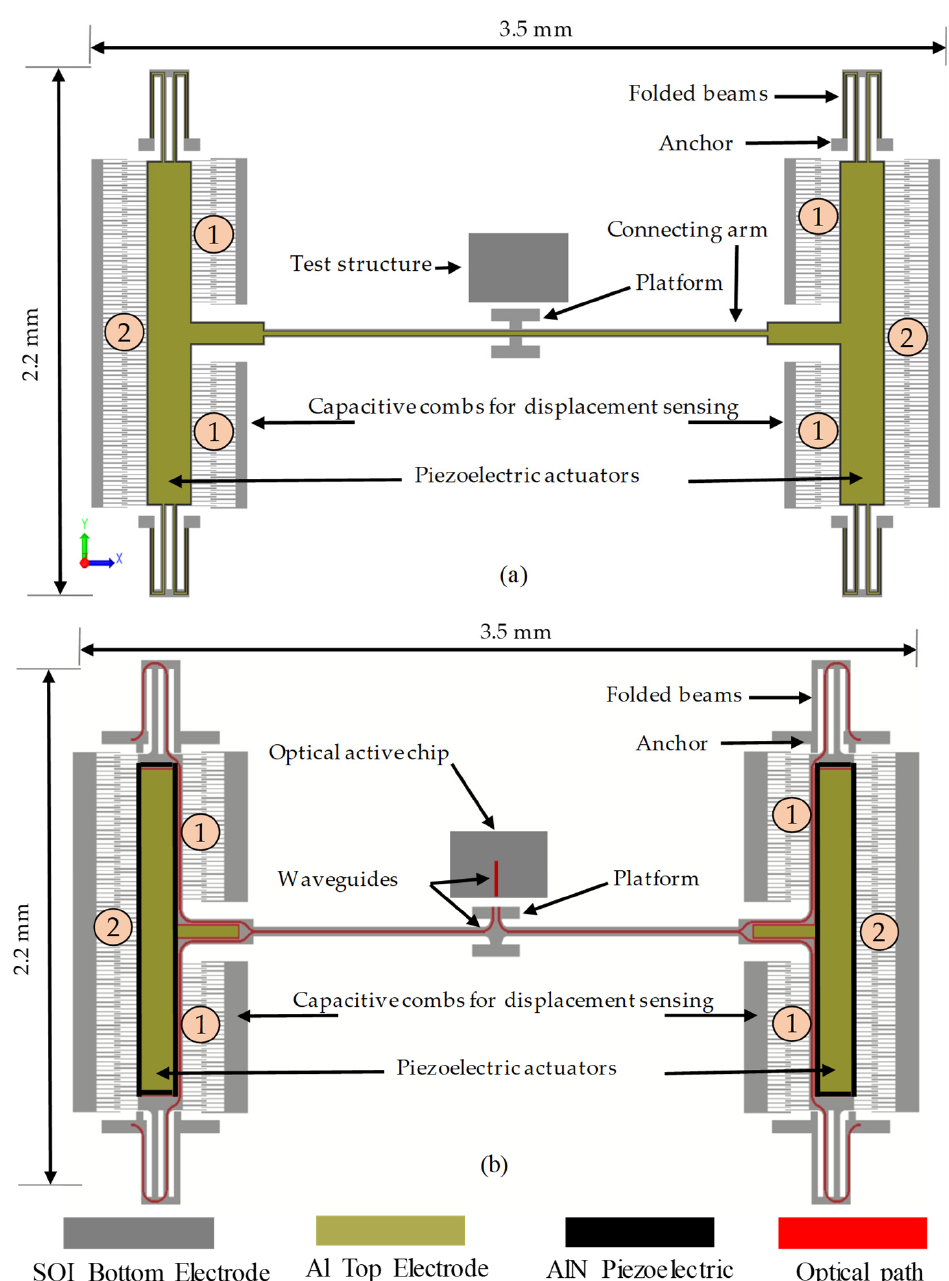
Figure 1. Schematic of the out-of-plane piezoelectric actuator: ( a ) the fabricated device, where the H-shape platform is aligned to a fixed test structure, and ( b ) a modified version (not fabricated) that accommodates waveguides on the platform for optical routing to align to an active optical